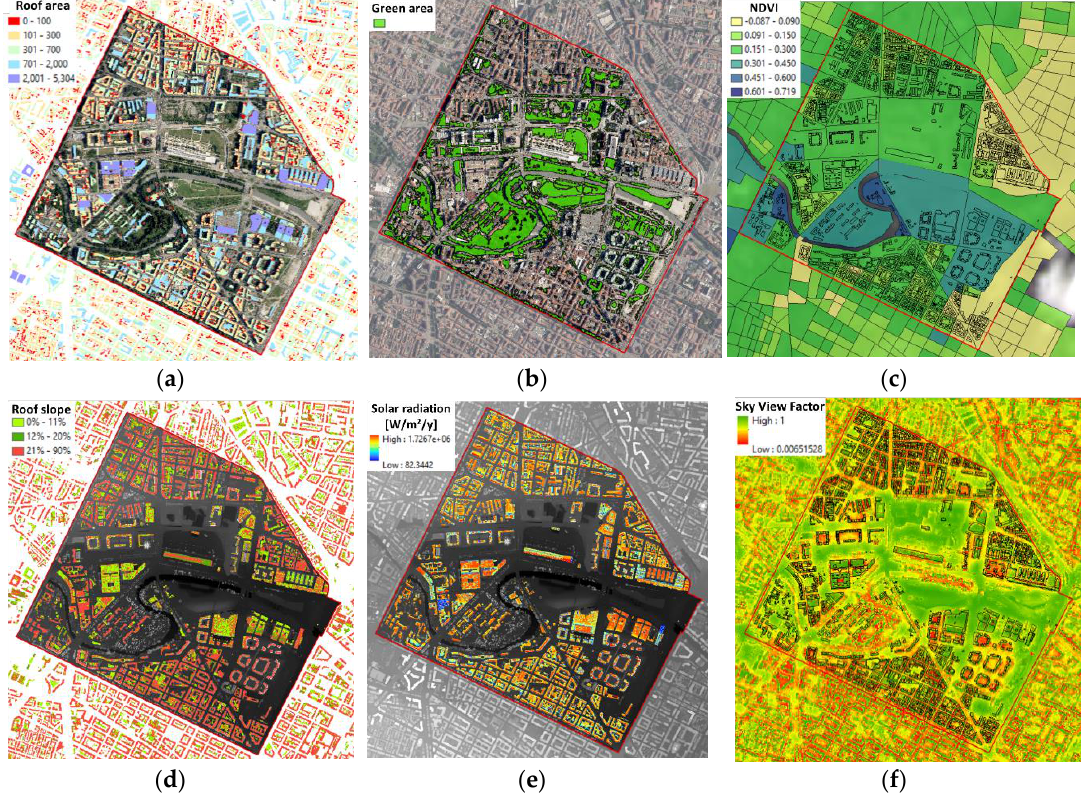
Figure 14. Analysis of the existing and potential green roofs in the ‘EnviPark’ area: ( a ) roof area calculated using the municipal technical map; ( b ) extraction of the green area with the FA tool using orthophotos (0.1 m); ( c ) NDVI calculated with Landsat 8 (25 August 2016); ( d ) calculation of the roof slopes and ( e ) annual solar radiation calculated using the DSM (0.5 m); ( f ) sky view factor calculated using the DSM (5 m).